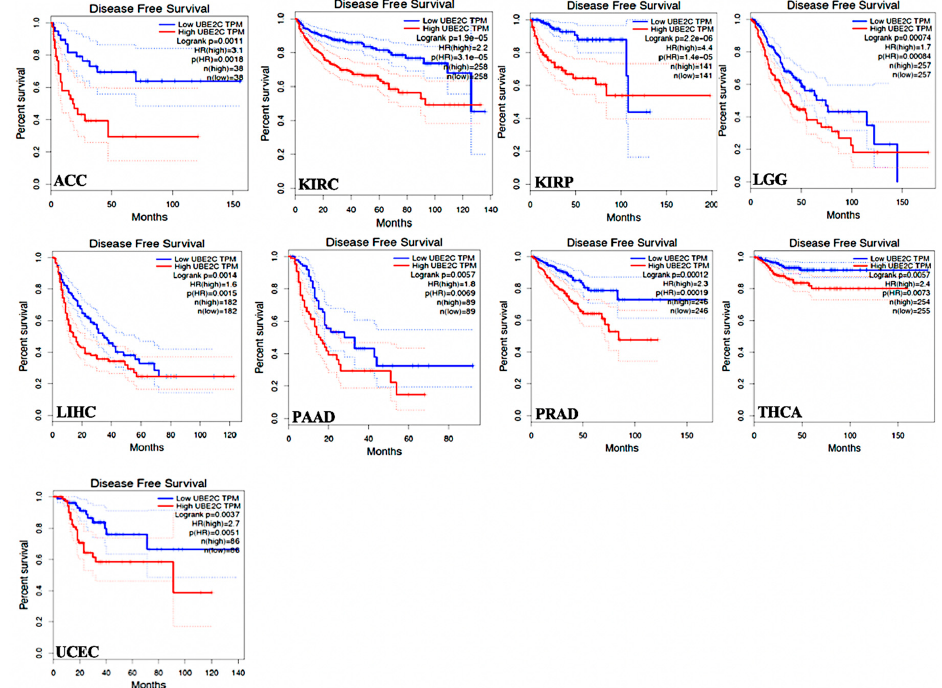
Figure 4. DFS time between UBE2C higher-expression-level and UBE2C lower-expression-level tumors in the TCGA tumor types with worse prognosis. Red line shows the cases with highly expressed UBE2C and blue line is indicated for the cases with lowly expressed UBE2C . HR: hazard ratio.